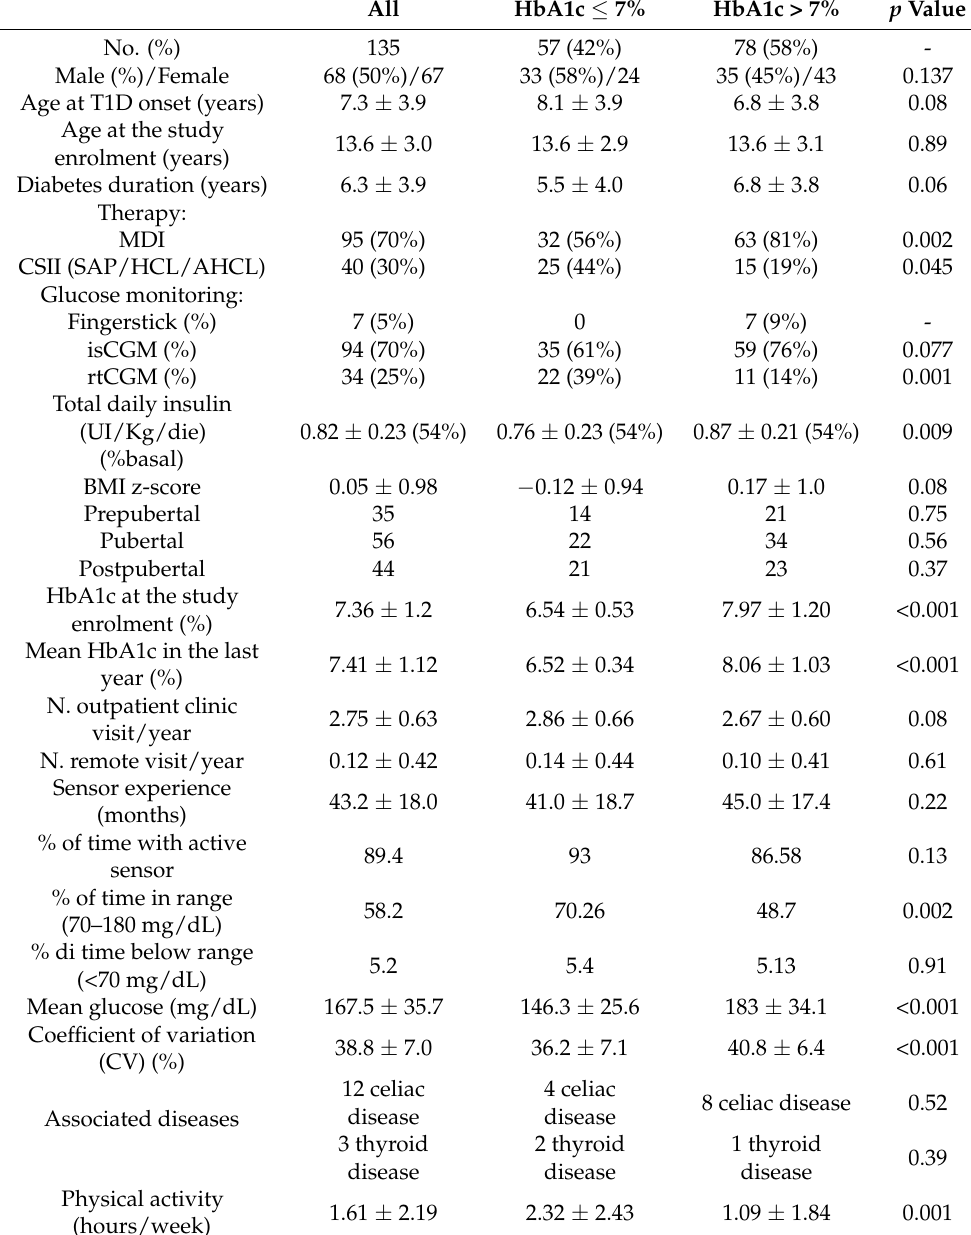
Table 1. Population enrolled: demographic, auxological and metabolic data. 14 day time parameters of glucose control. Mean ±